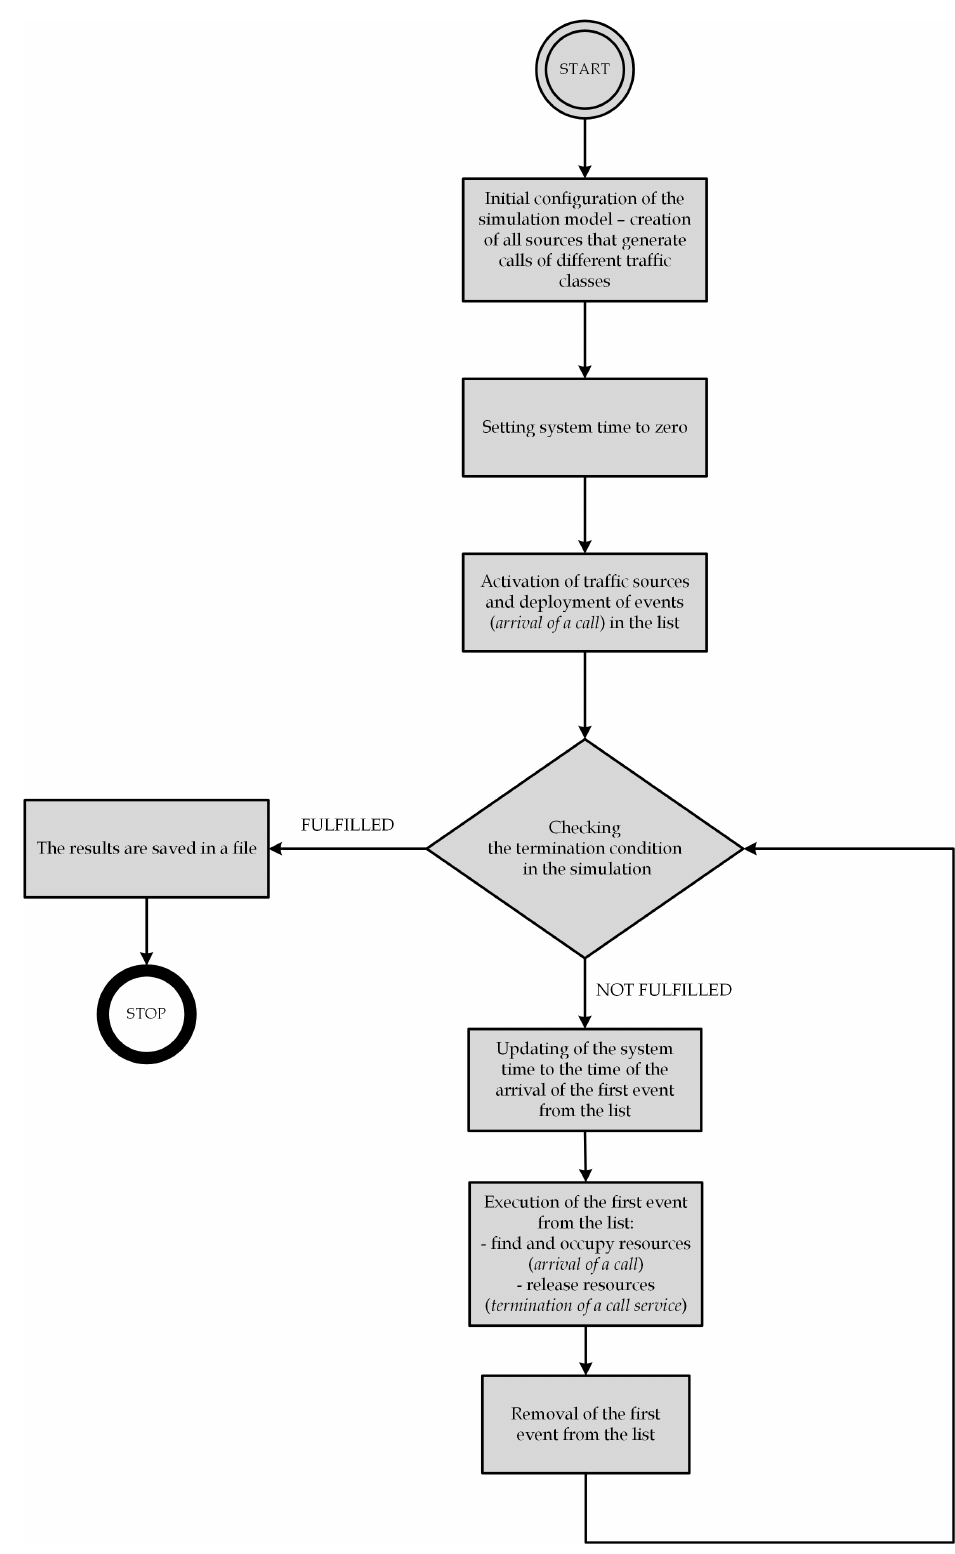
Figure 7. Simulation